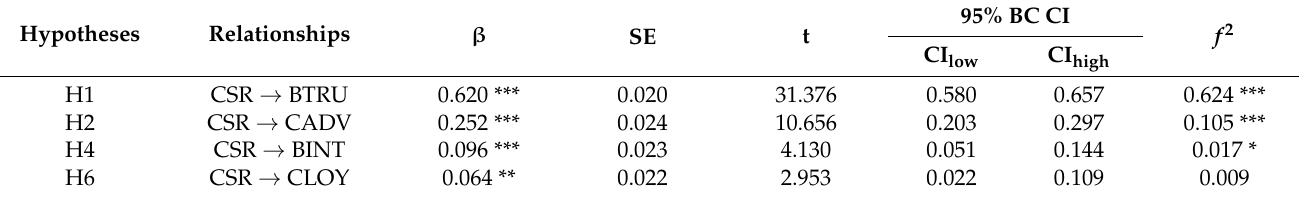
Table 6. Testing for direct effects.